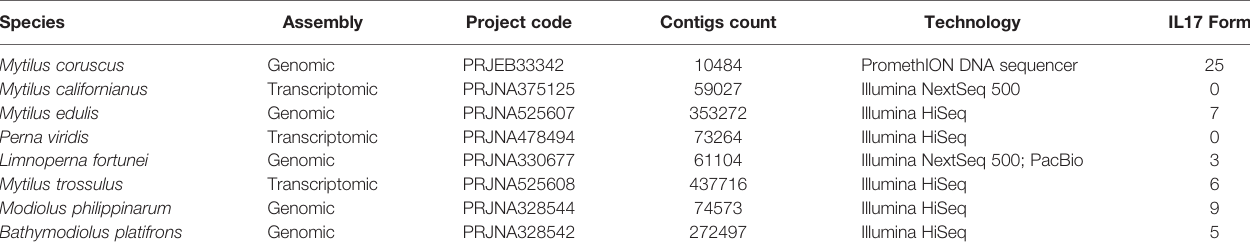
TABLE 4 | Homologous sequences to the Mytilus galloprovincialis IL-17 isoforms found in other analyzed Mytilidae species.